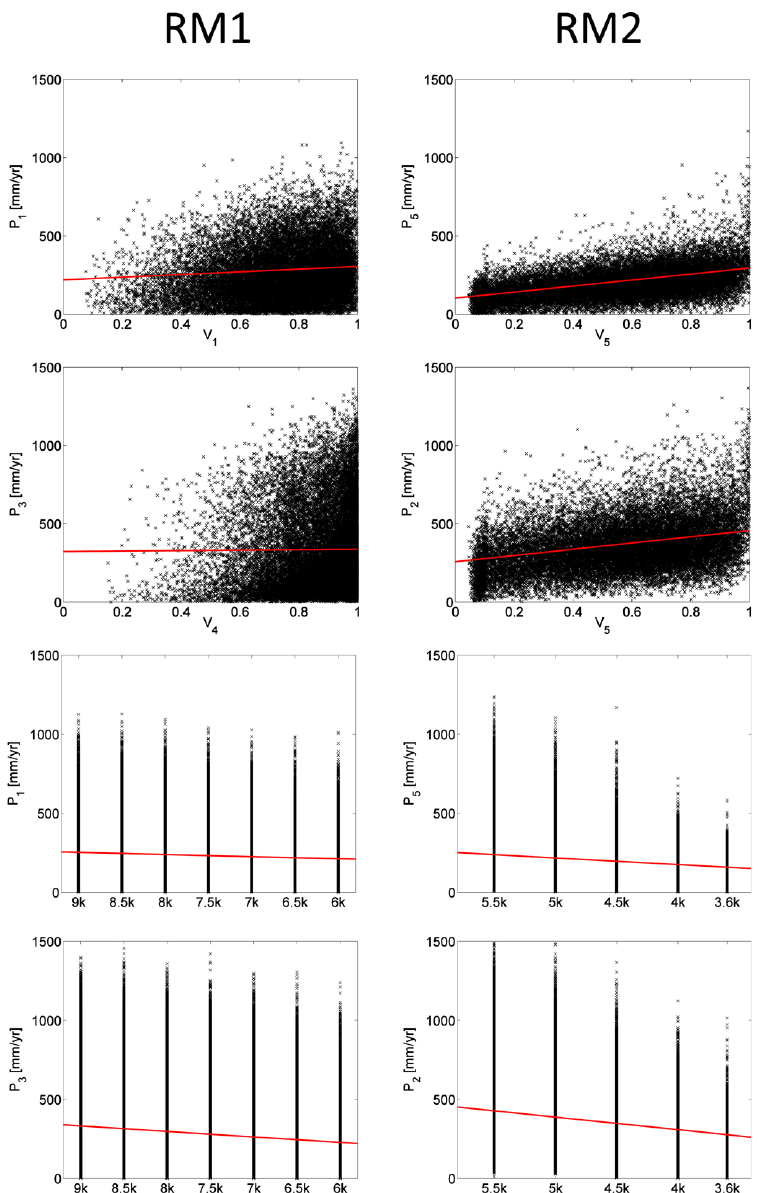
Fig. 4. Relation between precipitation ( P ), vegetation cover fraction ( V ) and orbital forcing from the stationary simulations with PlaSim- VECODE-tr. The indices of P and V refer to the specific grid cells labelled in Fig. 2 (for example, P 3 vs. V 4 shows P at cell 3 versus V at cell 4 for all years and simulations). The four lower panels show the relation between P and orbital forcing. Left: simulations used to derive RM1, right: simulations used to derive RM2. The slope of the red lines corresponds to parameters k ij and s i as obtained from the multiple regression, the intersects have been obtained by assuming mean conditions for all other predictor